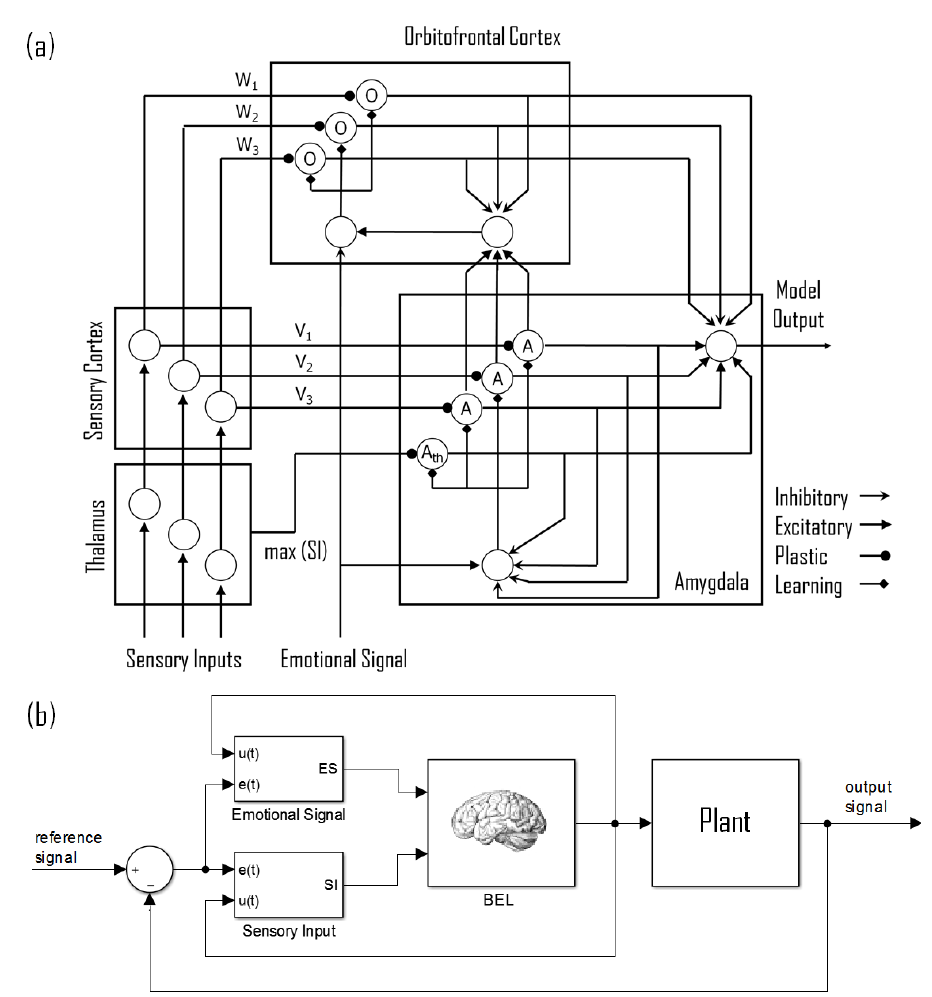
Figure 4. ( a ) BEL computational model, ( b ) SISO closed-loop control system with BELBIC